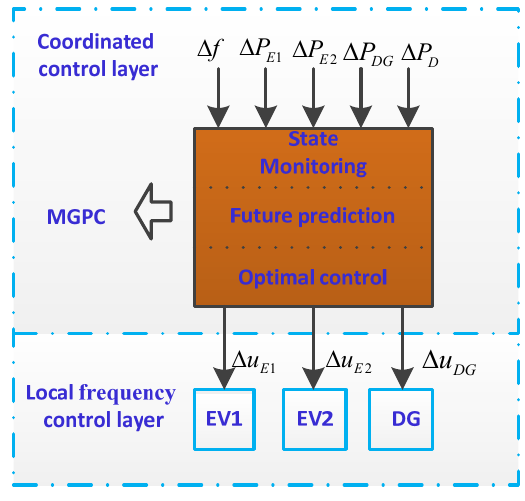
Figure 5. The structure of the proposed coordinated LFC controller based on